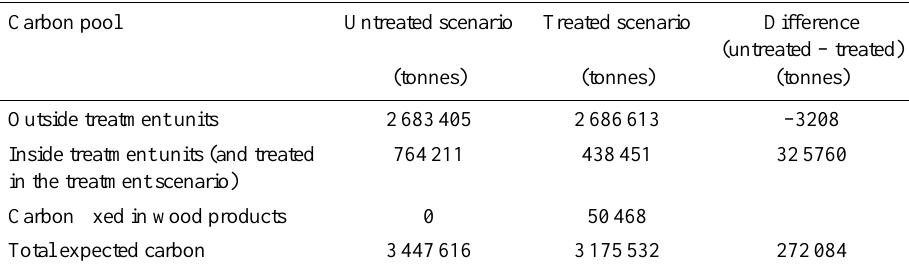
Table 3. Expected carbon (tonnes) for the non-treatment and treatment scenarios. Outputs are reported for the simulation year 2004 immediately after fuel treatments. Expected carbon is the estimated amount remaining after a random ignition and wildfire event in the study area, as estimated by simulating 30000 wildfire events. Total stand carbon includes live and dead trees, live and dead understory, standing and downed dead wood, litter and duff. Carbon stored is harvested carbon that is fixed in manufacturing products (e.g. lumber). Soil carbon is not modelled by FVS-FFE and is, therefore, not included in the calculations.